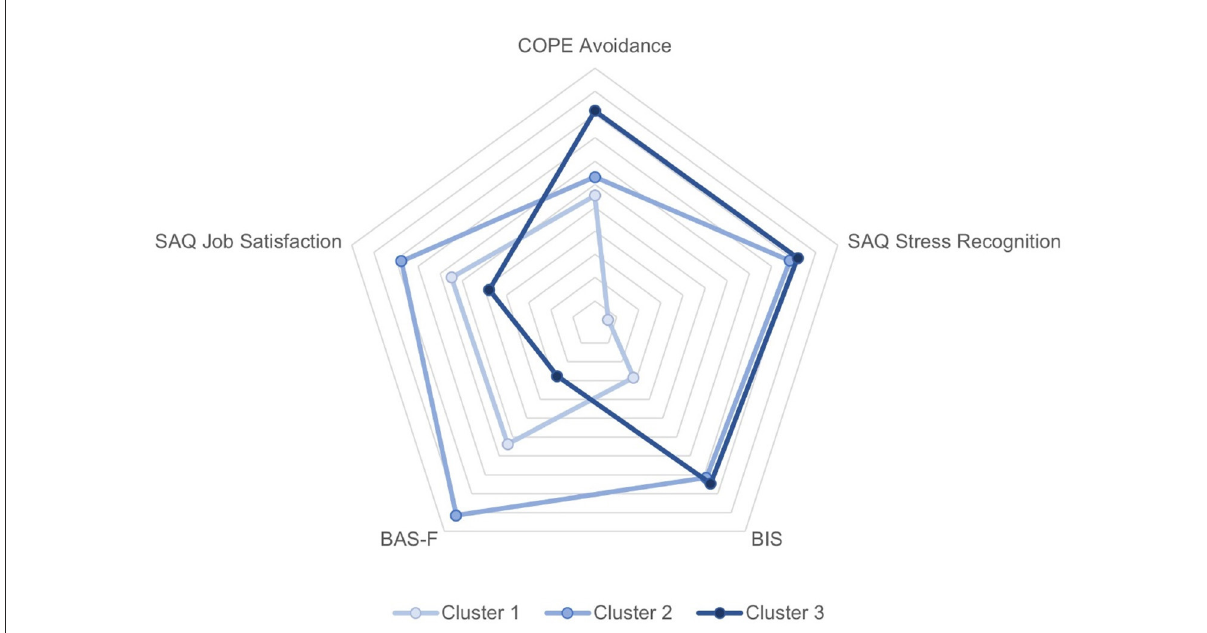
FIGURE1 Radar plot of mean scores on personality, coping and safety culture by clusters. A greater distance from the center represents a more positive score on the scale.